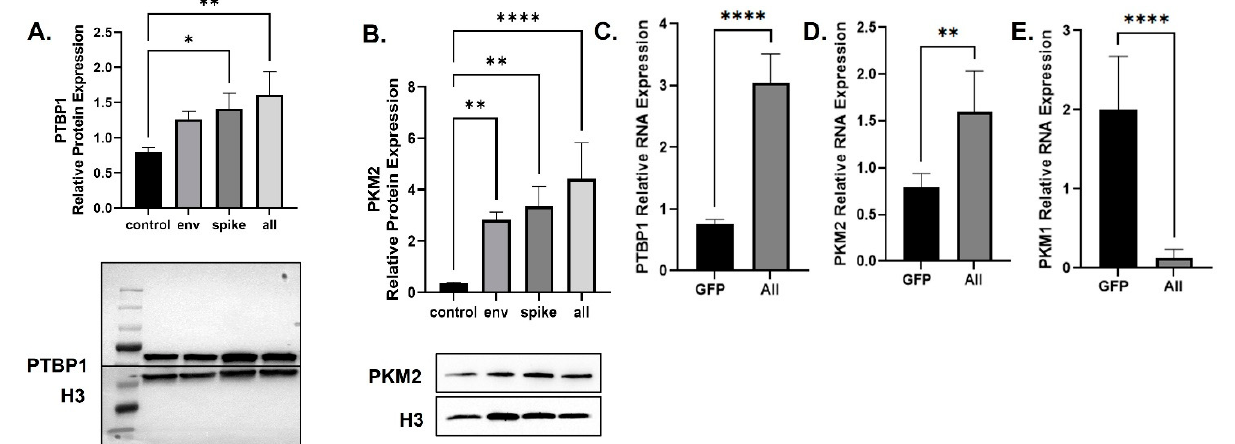
Figure 3. Changes in Proteins Responsible for Metabolic Reprogramming. Expression of PTBP1 ( A ) and PKM2 ( B ) proteins isolated from untreated or BEAS-2B transfected as indicated. Quantification of the relative protein levels was determined from the band intensity using ImageJ software and normalized relative to the H3. PTBP ( C ), PKM1 ( D ), and PKM2 ( E ) mRNA expression was obtained by qPCR using BEAS-2B transfected with all SARS-CoV-2 plasmids except for the membrane. Bar graphs represent the means ± S.D. of at least two independent experiments. Data represent the mean ± S.D. Results were judged statistically significant by ANOVA (* p < 0.05; ** p < 0.01; **** p < 0.0001).